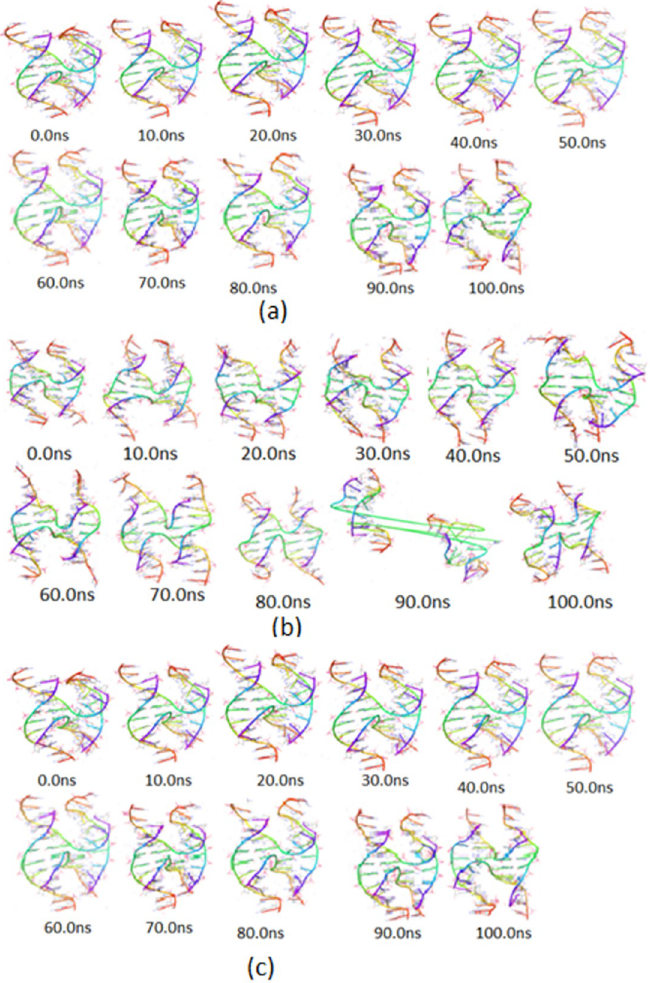
Fig 1. A series of snapshots taken at periodic intervals of 10.0 ns during MD simulation of the four–way DNA junction at neutral pH and temperature (a) 200K, (b) 300K and (c) 310K, respectively. supporting information S1a–S1d Table. S1a Table is shown for the initial structure, i.e., pre- dynamics. While S1b Table depicts the torsion angles calculated for MD simulation done at 200K temperature for 100 ns time. S1c Table represents the torsion angles calculated for MD simulation done at 300K for the time of 100 ns, while S1d Table demonstrate the torsion angle parameters at 310K. The term ± Gauche ( ± g ) and trans ( t ) have been used to refer the broad conformational space and Klyne-prelog notation such as syn , anti, synclinal( sc ), anticlinal ( ± ac ) have been used for more detailed analysis [43]. From S1a Table, we have observed that there is a considerable correlated conformational activity between torsion angles α and β , these torsion angles oscillate within gauche( g -) and trans( t ) regions respectively for most of the residues. There is symmetric absence of torsion angles α and β for residues 1, 11, 21 and 31. Similar symmetric absence of torsion angles ε and δ are found for the residues 10, 20, 30 and 40, respectively. The torsion angle γ shows consider- able dynamical excursion in the gauche ( g -) regions to gauche ( g +) regions with exception of residues 6, 20, 31, and 40, which are in trans regions. The torsion angles δ , show anticlinal ( ac )